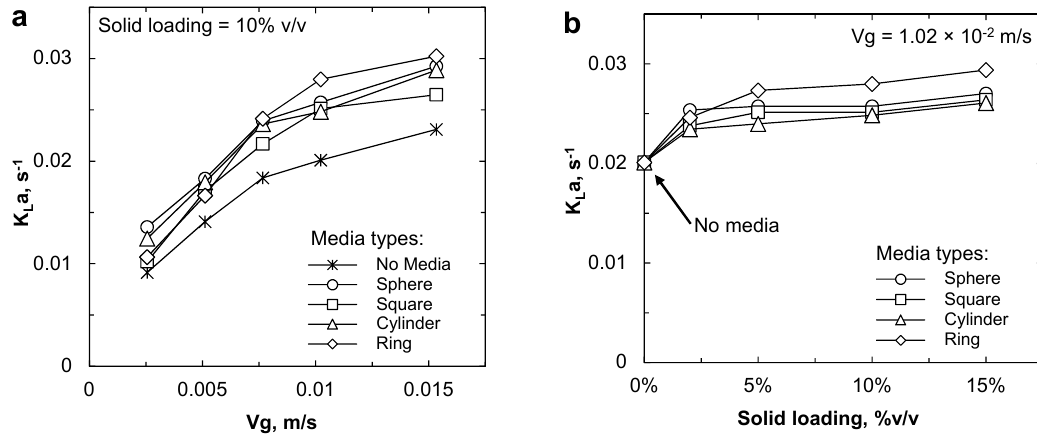
Figure 7. Overall mass transfer coefficient (K L a) in BCR of each solid media type with: ( a ) superficial gas velocity (Vg) and ( b ) solid loading.